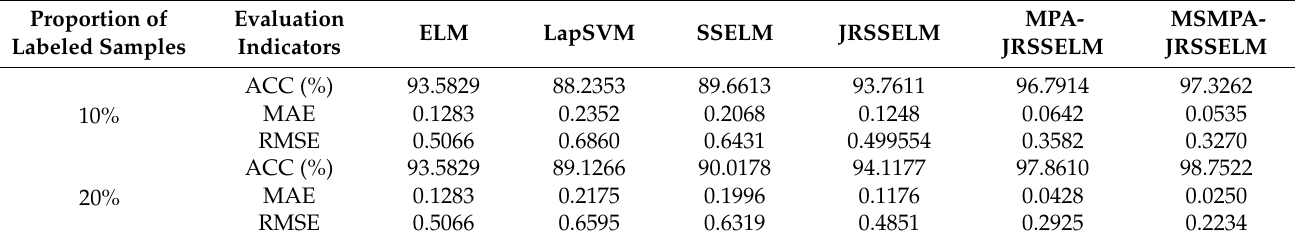
Table 8. Performance of each model on well